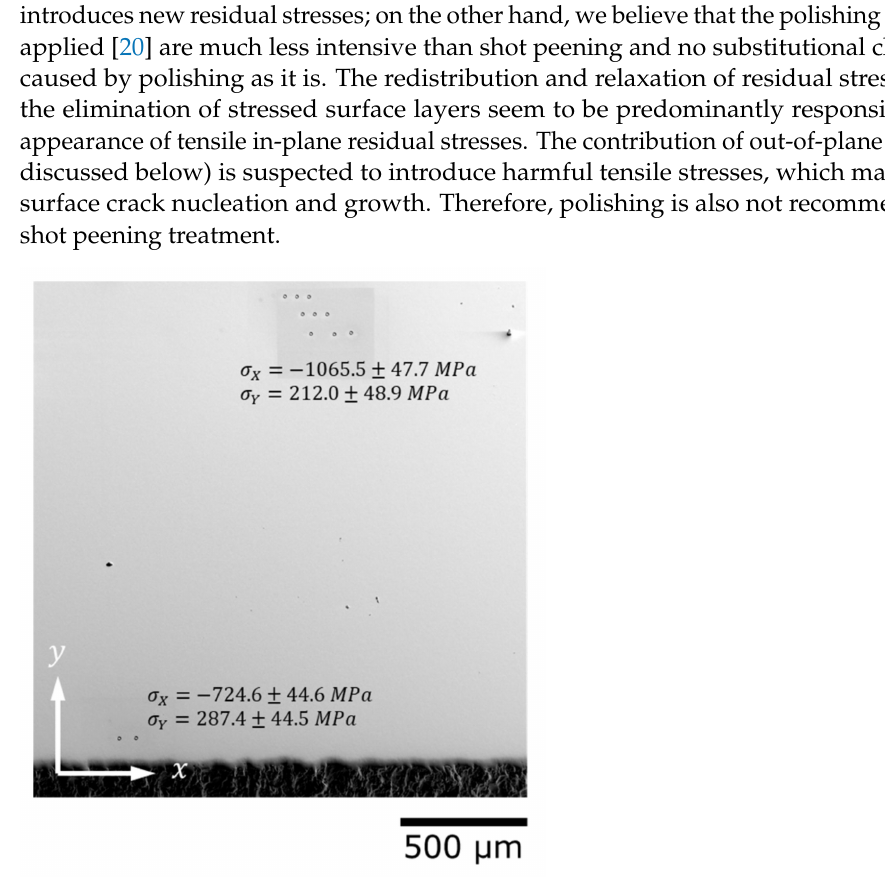
Figure 9. RS under shot peened area— Face III 7.5 × 5 mm 2